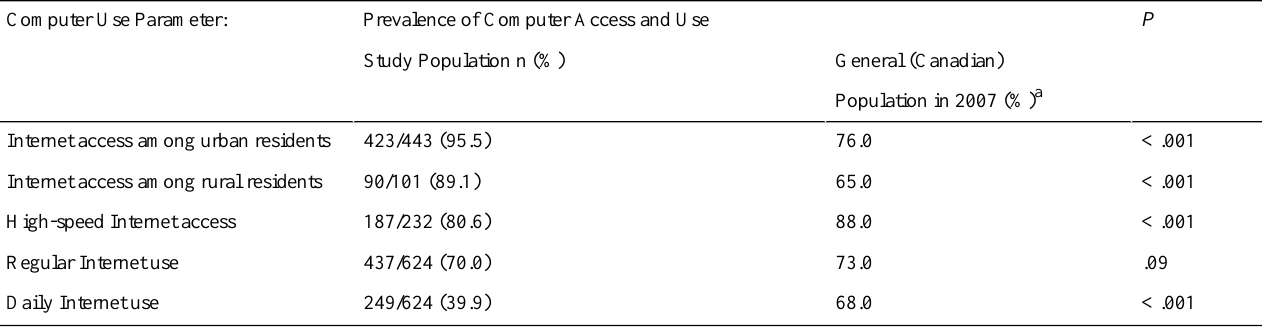
Table 3. Comparison of Internet use habits among our tertiary care patient cohort and the general Canadian population